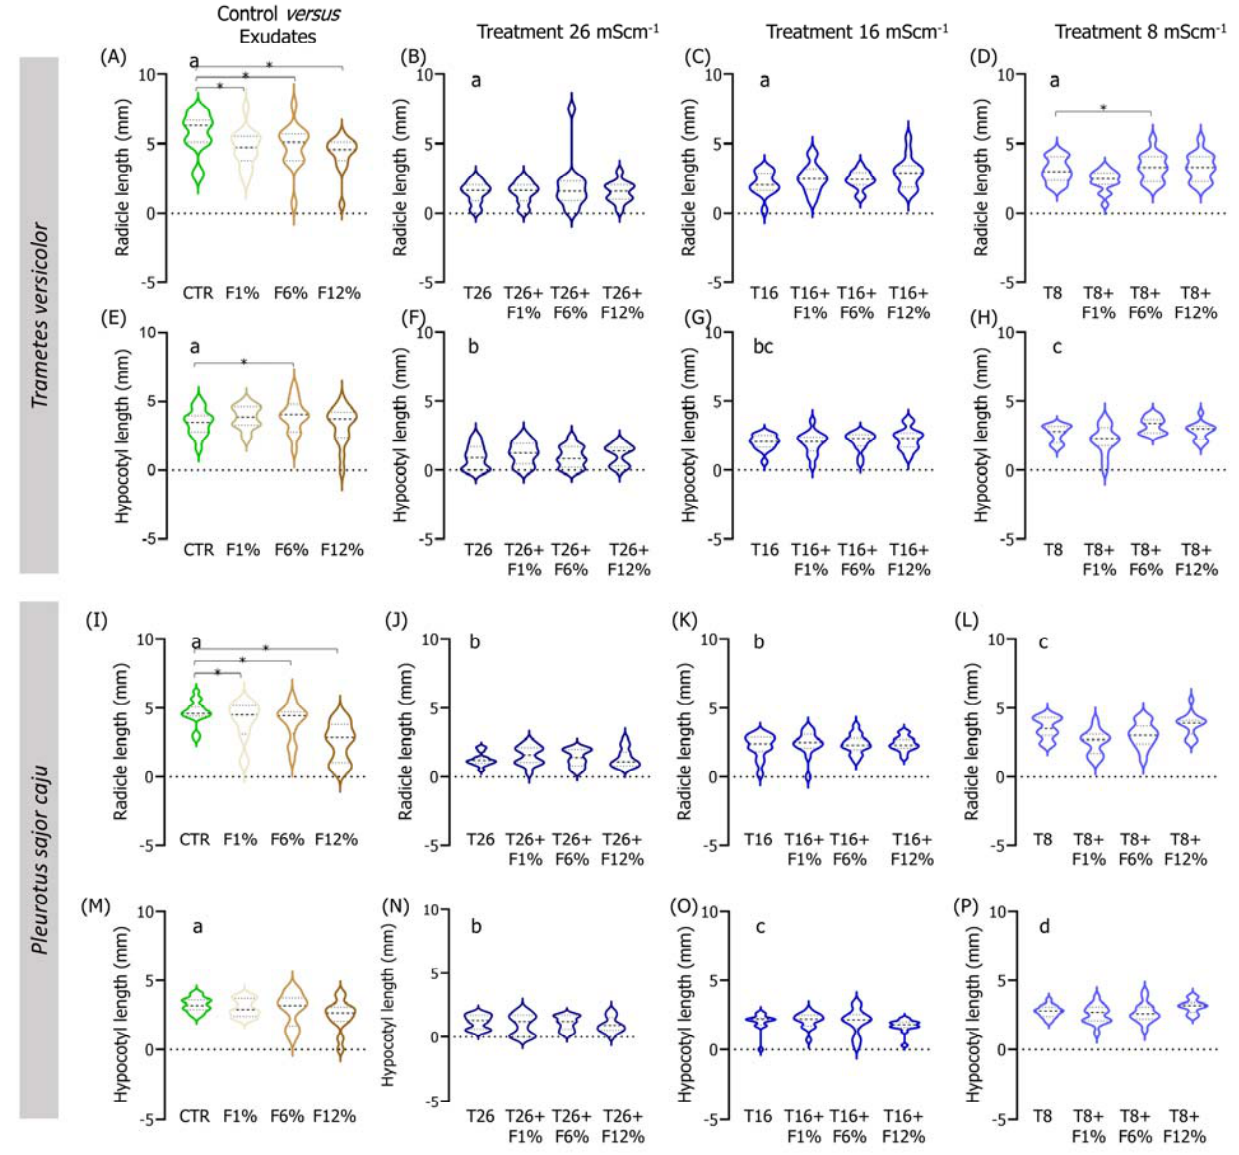
Figure 5. Violin plots of the seedling length of Lens culinaris germinated in LUFA 2.2 soil salinized at three different levels (8, 16, and 26 mS · cm − 1 , designated as T8, T16, and T26, respectively) and supplemented with fungi exudates at three levels (1%, 6, and 12%, designated as F1%, F6%, and F12%, respectively). Graphics ( A – H ) present the results obtained from soil moistened with Trametes versicolor exudates, and graphics ( I – P ) present the results obtained from soil moistened with Pleurotus sajor caju exudates. CTR stands for control soil. Letters (a, b, c, d) stand for homogenous groups assessed only between CTR and the salinity treatments at 96 ‐ h in each assessed endpoint (Holm ‐ Sidak, p < 0.05). The * stands for statistical differences between treatments (Holm ‐ Sidak, p < 0.05). Note: Data represented only by points means that no sufficient points were available for the construction of the